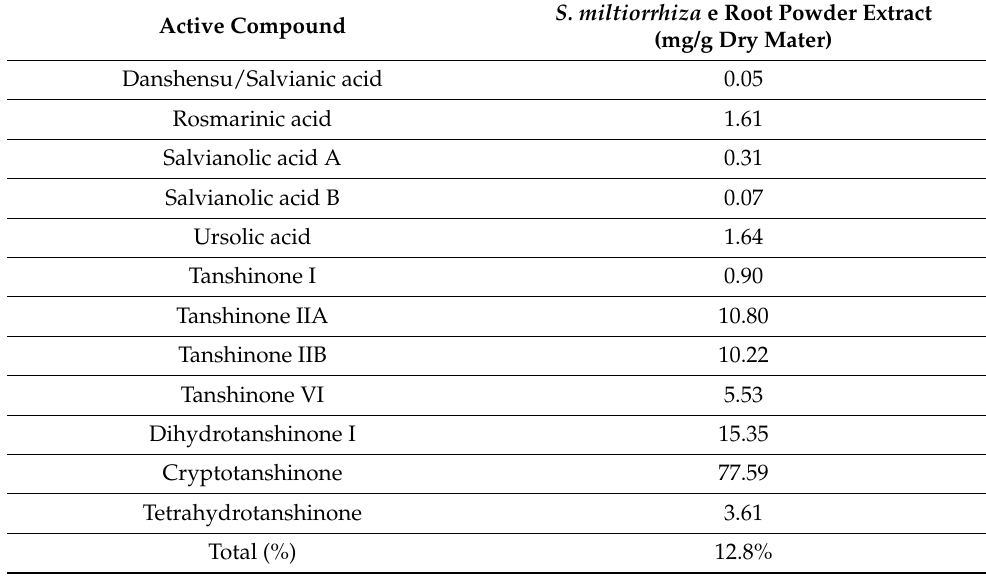
Table 1. Content of active compounds (expressed in mg/g of dry mater; except for the total expressed in %) measured in the S. miltiorrhiza root powder extract. Active